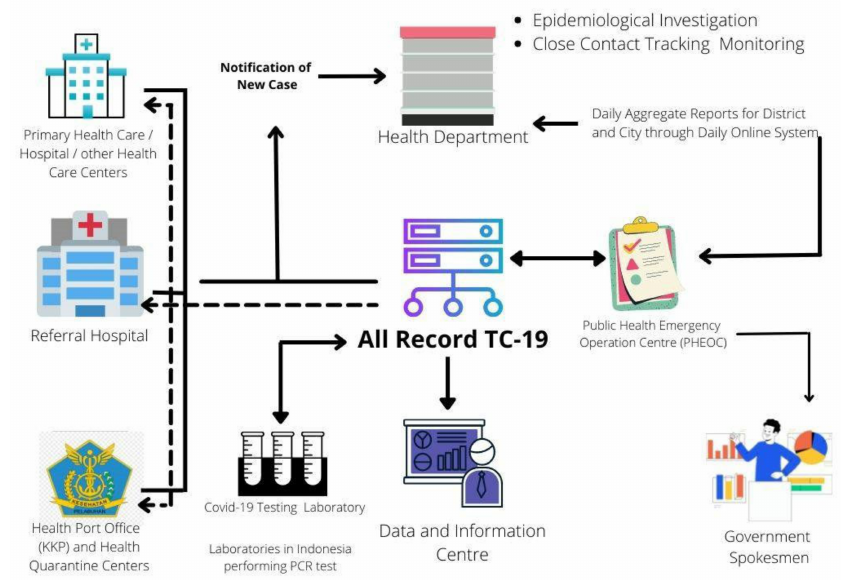
Figure 1. Information flow of COVID-19 recording and reporting